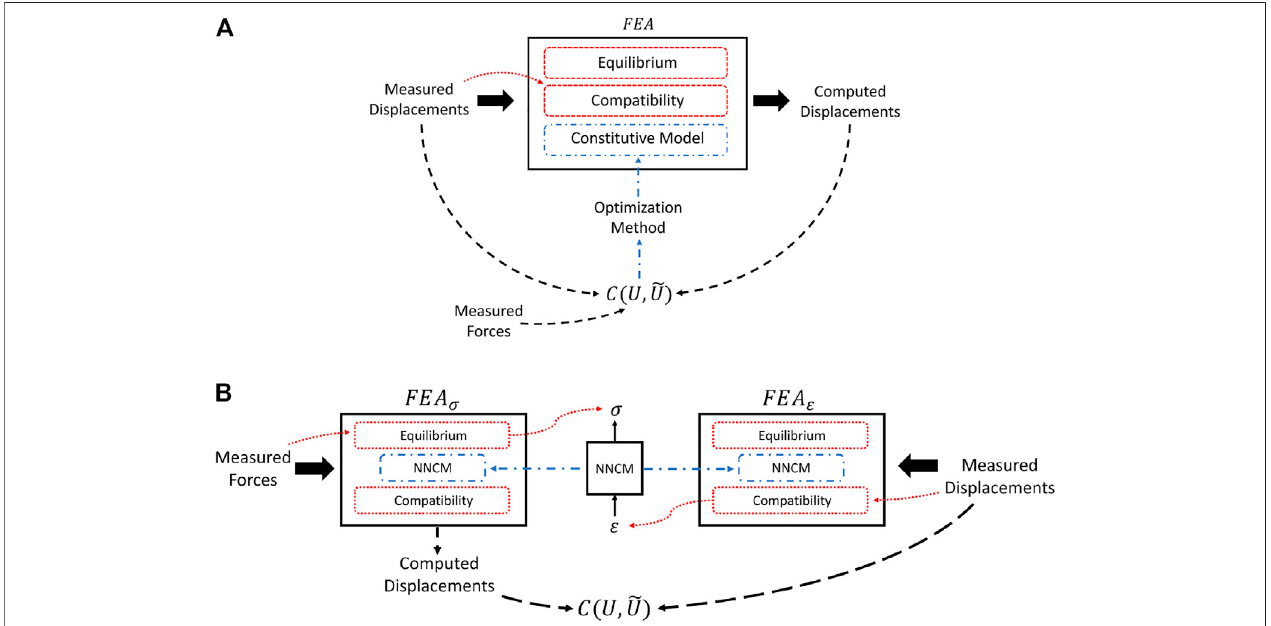
FIGURE 1 | (A) Summary of model-based inverse methods. Deformations computed in the forward problem are dependent on the estimated material properties and physical principles. Existing model-based QUSE methods that utilize force measurements use the data as input directly to the cost function or to calibrate the magnitude of the modulus estimates after the optimization procedure. (B) Illustration of AutoP training process. Applying force and displacement measurements in separate FEAs exploits equilibrium and compatibility requirements to generate physically consistent stresses and strains.